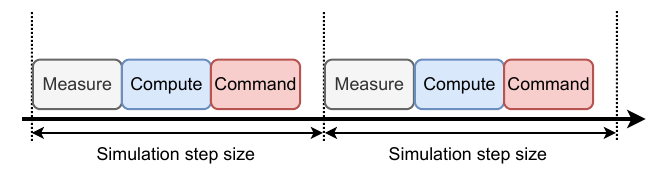
Figure 8. Real-time simulation timing diagram.